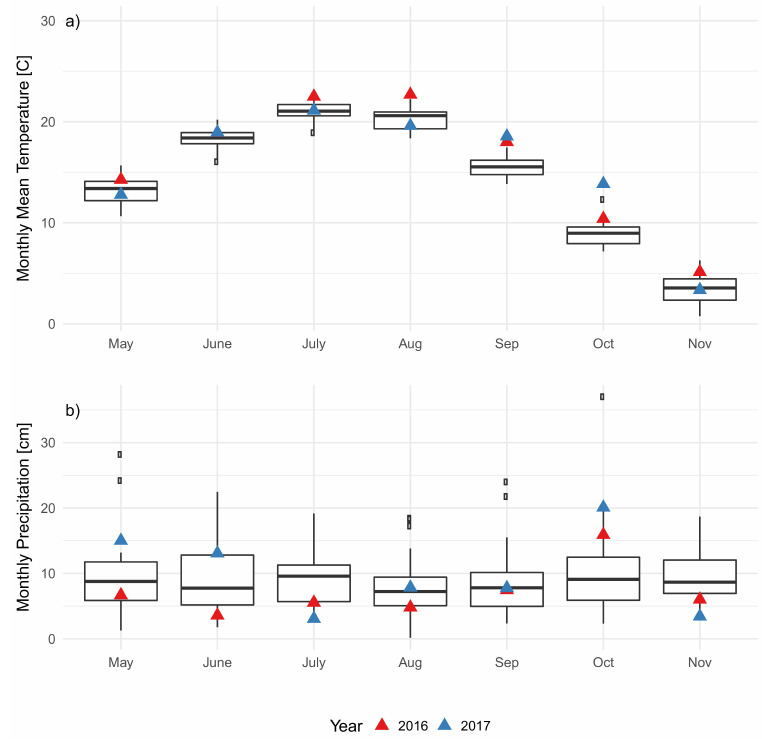
Figure 4. Monthly Mean Temperature and Total Precipitation in 2016 and 2017: ( a ) Monthly mean temperature was significantly higher than the 75% quartile range of the 30-year climatology for July, August, September, and November in 2016, and for September and October in 2017. ( b ) Monthly total precipitation was much higher in 2017 than in 2016 for May, June, and October, and the values for 2017 in those months were also higher than the 75% quartile of the 30-year climatology for total precipitation (box